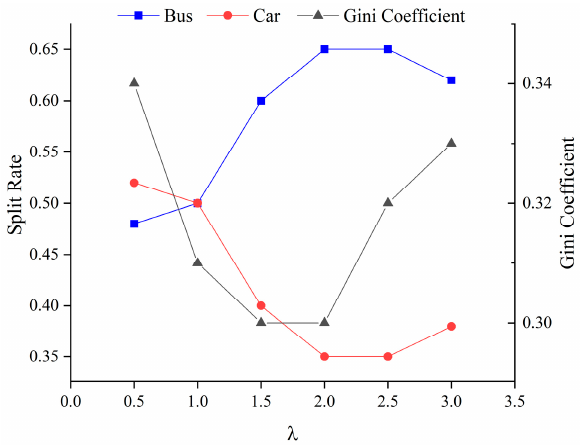
Figure 9. Impact of changing demand on optimal solution.